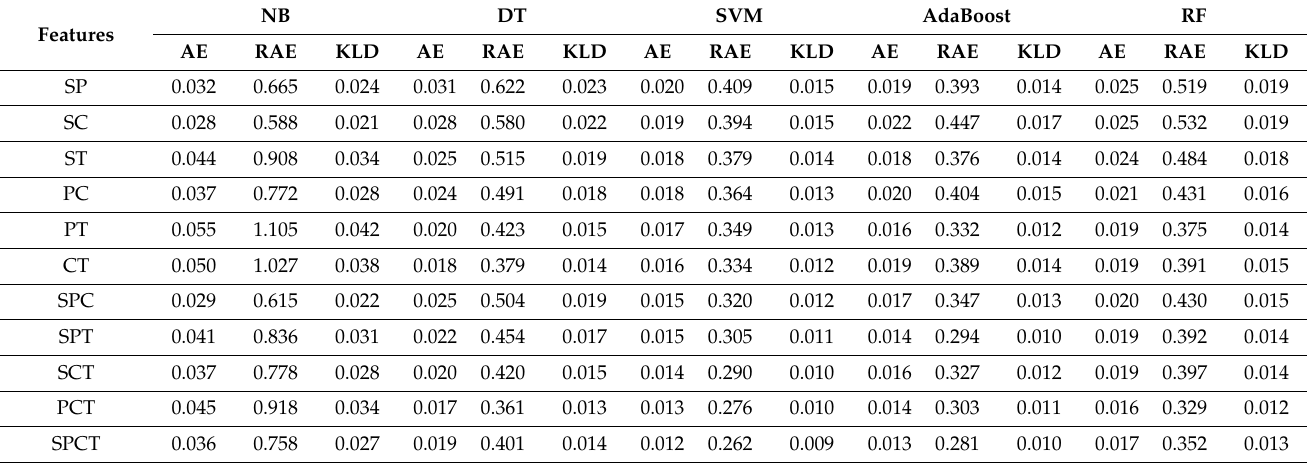
Table 9. Comparison of feature sets combination using ML classifiers on Sanders.